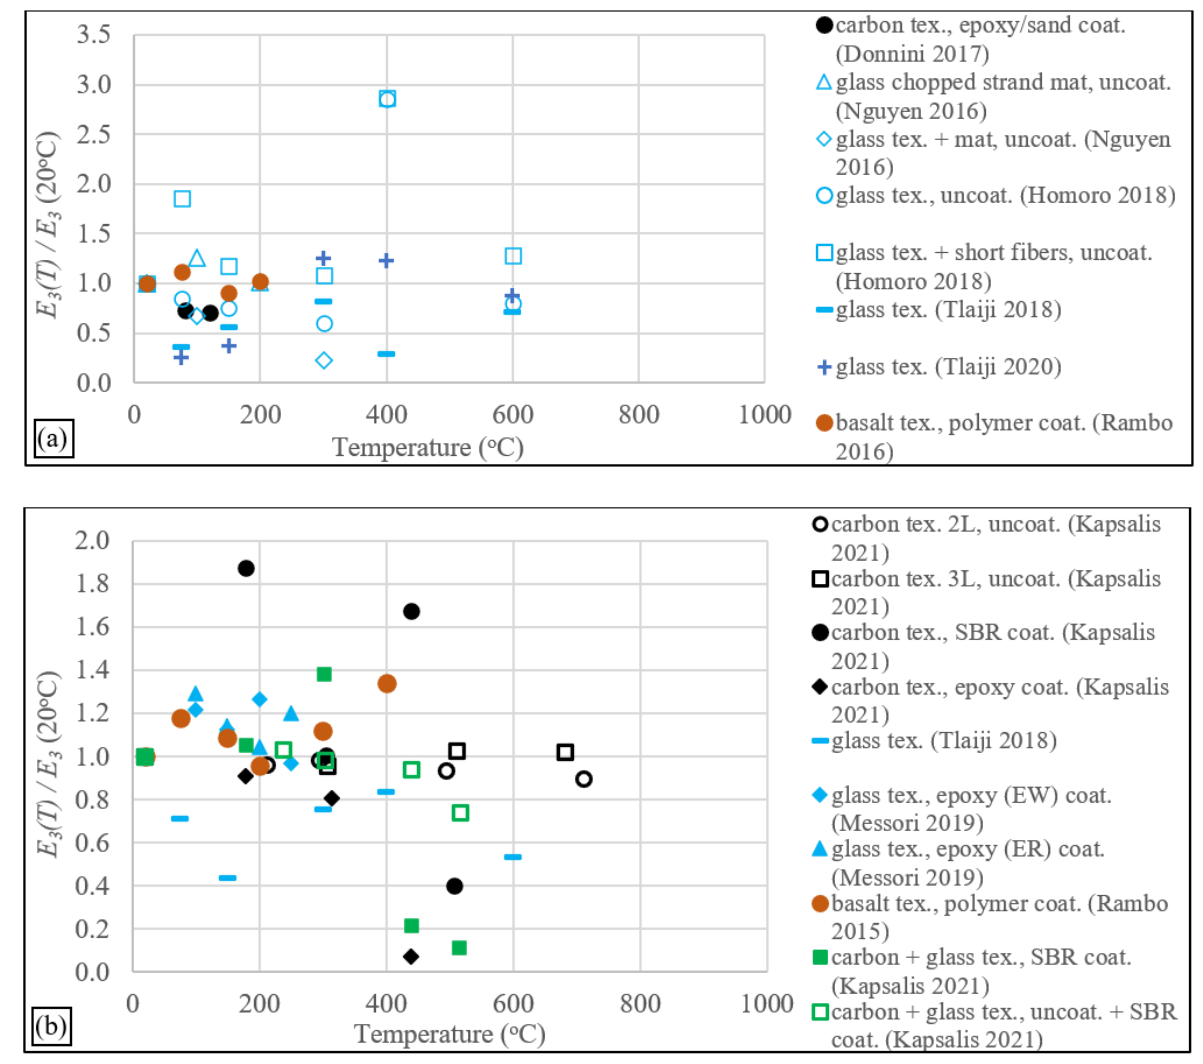
Figure 6. Post-cracking modulus ( E 3 ) versus exposure temperature for various TRC compositions; ( a ) specimens loaded while in heated conditions; ( b ) specimens tested after cooling down.